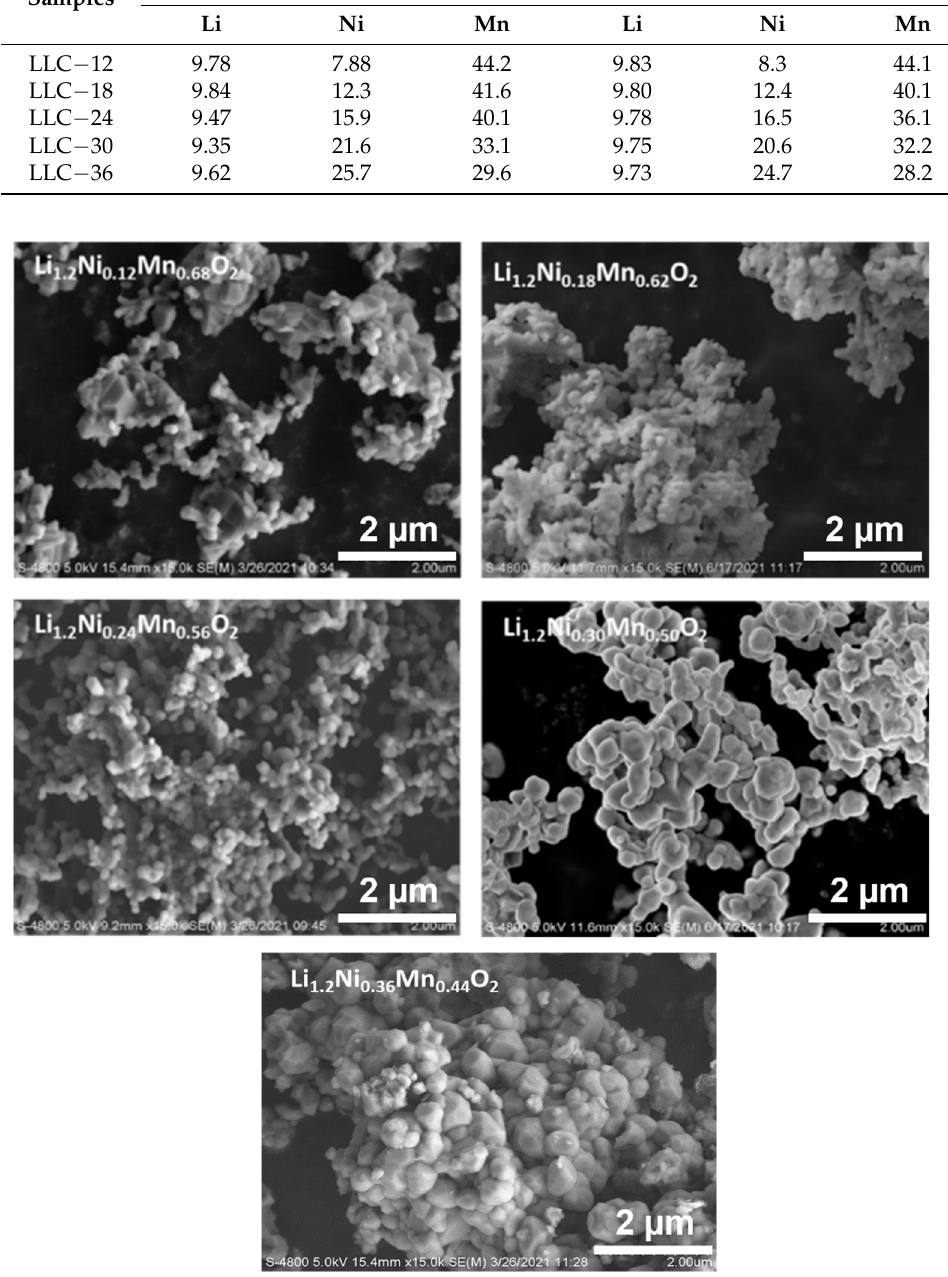
Figure 2. SEM image of all as-prepared LLCs powder samples. Table 1. Unit cell parameters of as-prepared LMR samples.